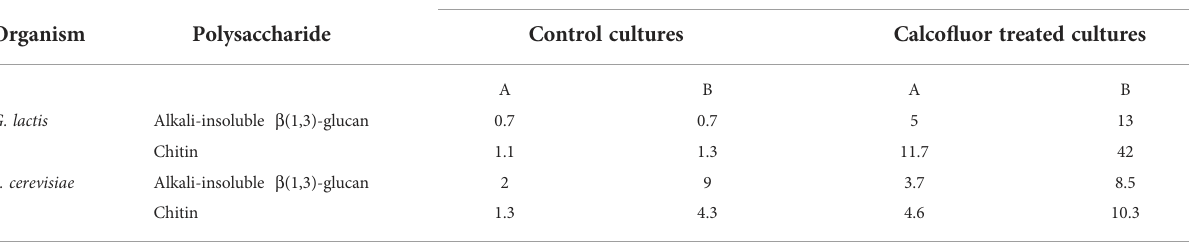
TABLE 1 Effect of Calco fl uor on the synthesis of cell wall polysaccharides in reverting protoplasts from G. lactis and S. cerevisiae .